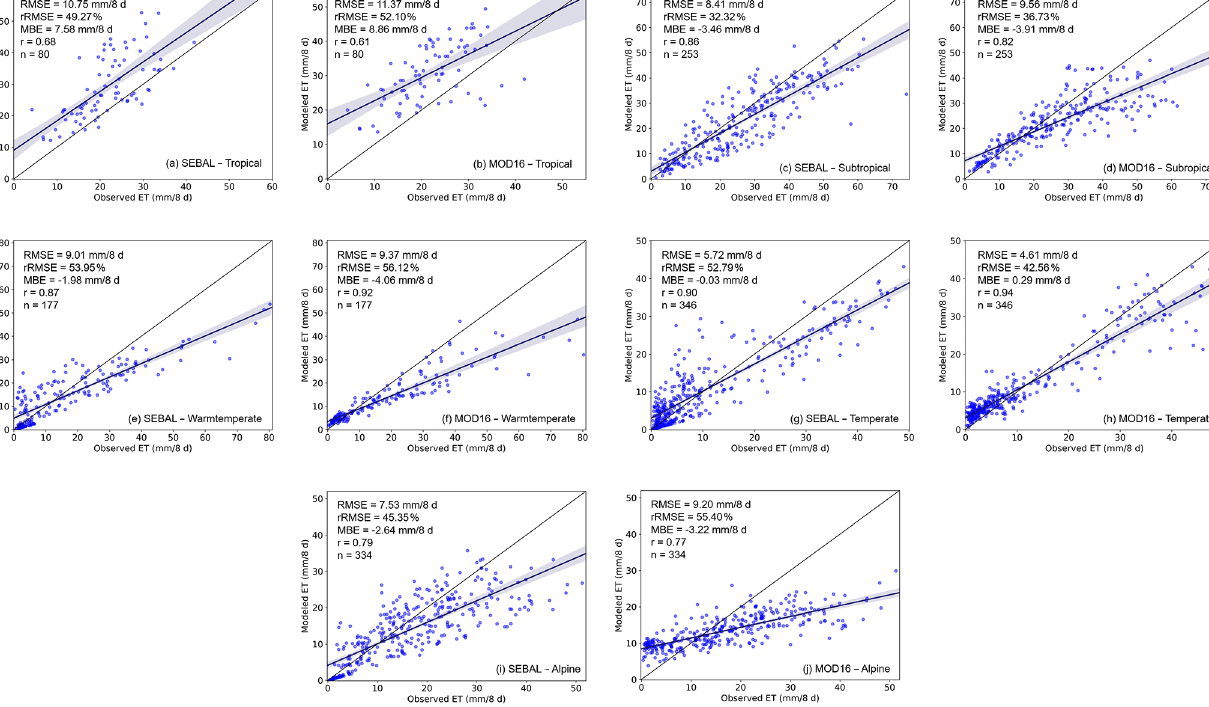
Figure 6. Validations for different climate zones. (a) SEBAL ET for tropical zones; (b) MOD16 ET for tropical zones; (c) SEBAL ET for subtropical zones; (d) MOD16 ET for subtropical zones; (e) SEBAL ET for warm–temperate zones; (f) MOD16 ET for warm–temperate zones; (g) SEBAL ET for temperate zones; (h) MOD16 ET for temperate zones; (i) SEBAL ET for alpine zones; (j) MOD16 ET for alpine